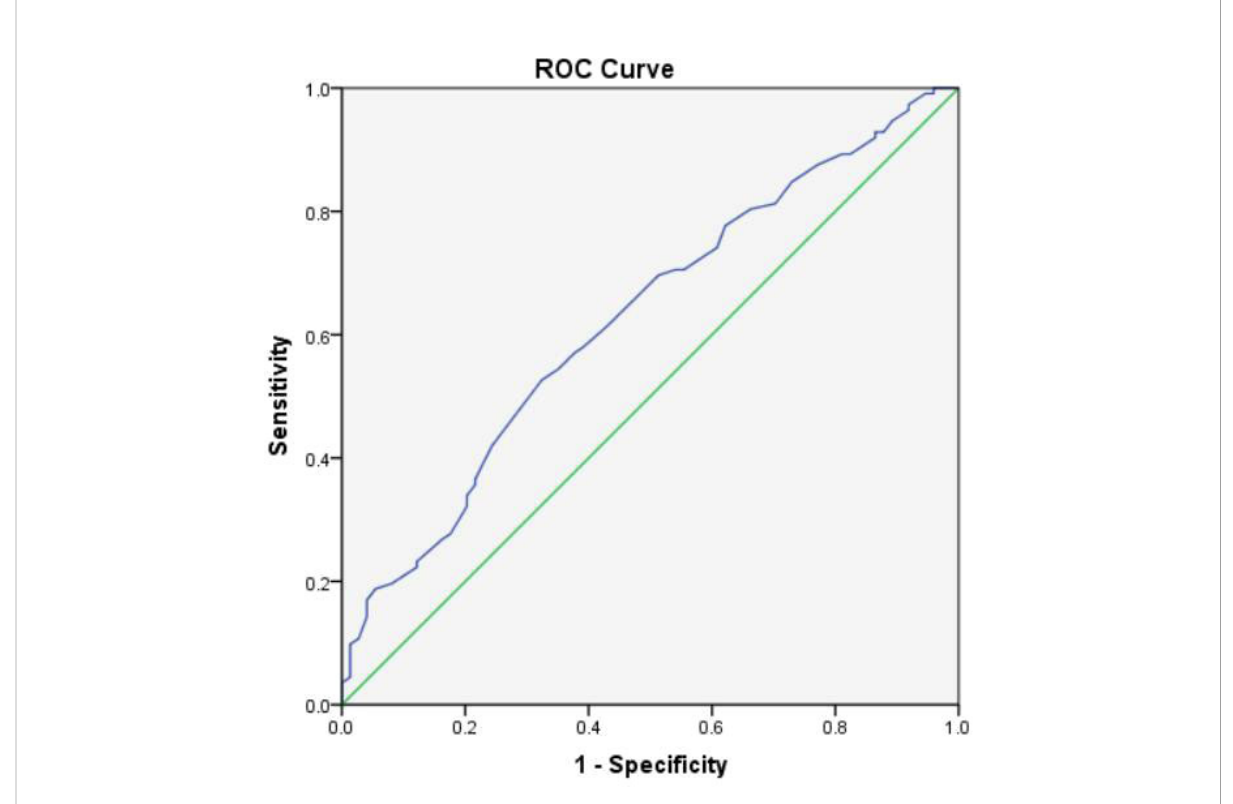
FIGURE 2 The ROC curve analysis to predict the optimal age for clinical signi fi cance EUS-FNA (the area under the curve=0.626).